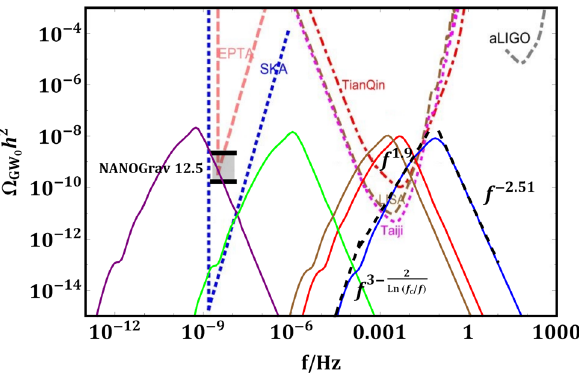
Fig. 6 The present induced GWs energy density parameter ( (cid:2) GW with respect to frequency. The solid purple, green, red, blue, and brown lines associate with Cases A, B, C, D, and F of Table 1, respectively. The power-law form of (cid:2) GW is illustrated by black dashed line for 0 Case